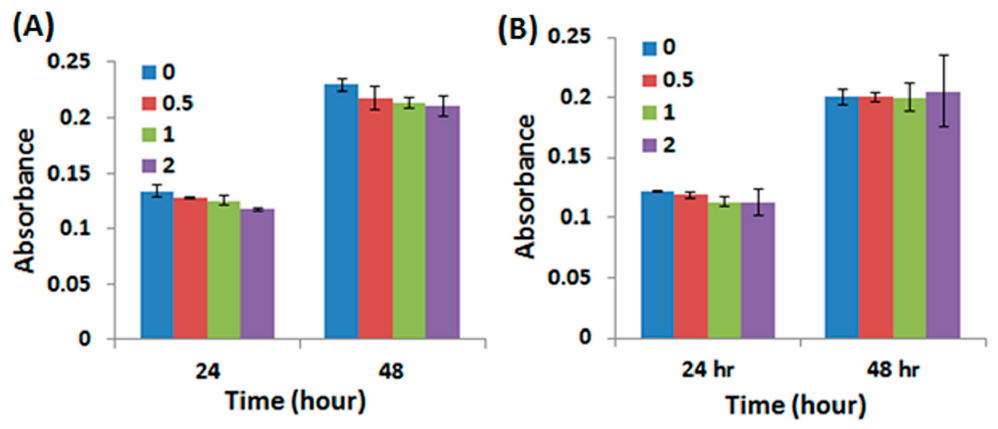
Figure 6. The cell proliferation of ( A ) WJMSCs and ( B ) chondrocytes cultured on the PU/HA hybrid scaffolds for 24 and 48 h.